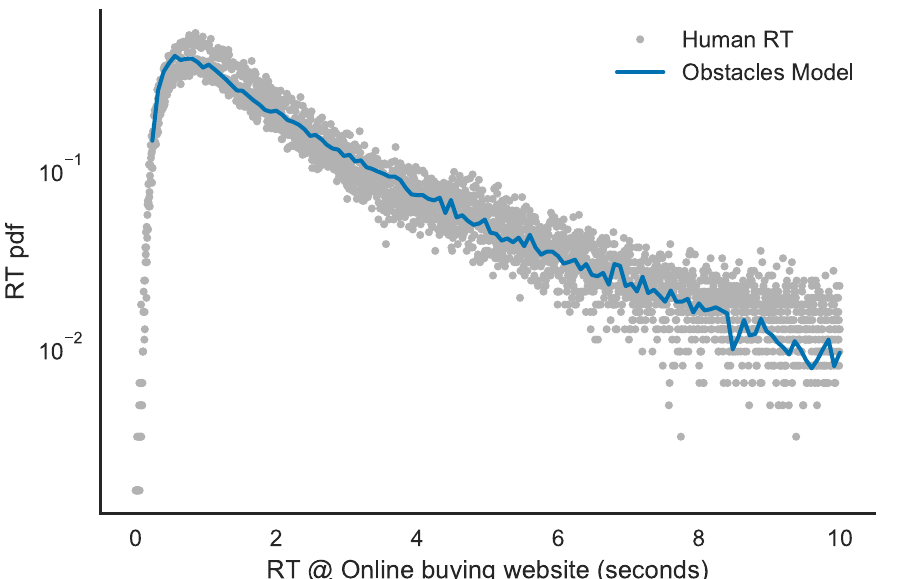
Fig 4. Generality. Model extension to on-line buying decision-making. Dots show response times between clicks of users doing a product search, i.e. how long users take to decide for (more information of) a products; blue line shows best RT fit of model showing an almost perfect match (Kolmogorov-Smirnoff Test, D